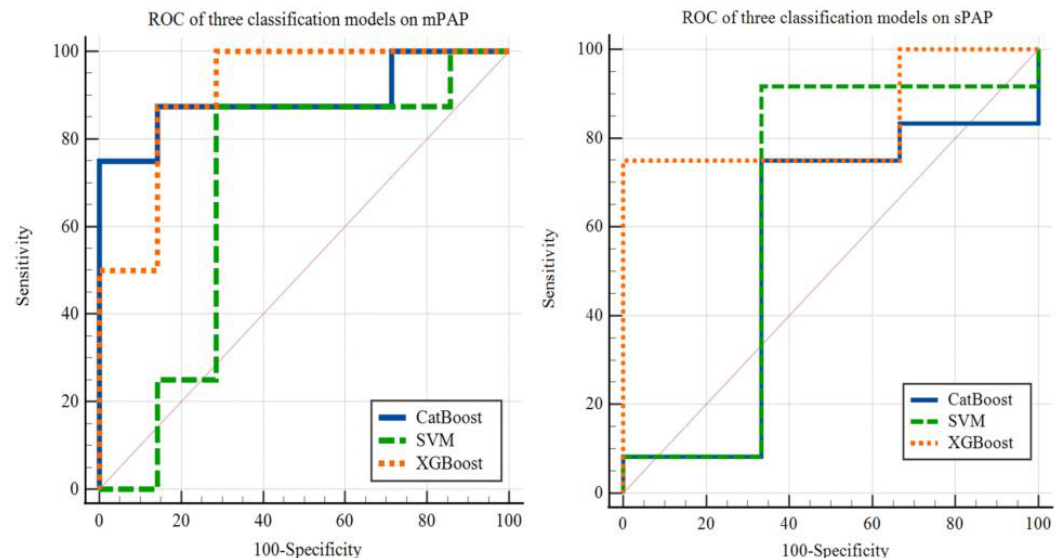
Figure 7. Area under the receiver operating characteristic curve (AUC) shows XGBoost model performs better than CatBoost and SVM model. The AUC of XGBoost model classification on mPAP and sPAP is 0.911 ( p < 0.001) and 0.833 ( p = 0.0057), respectively.